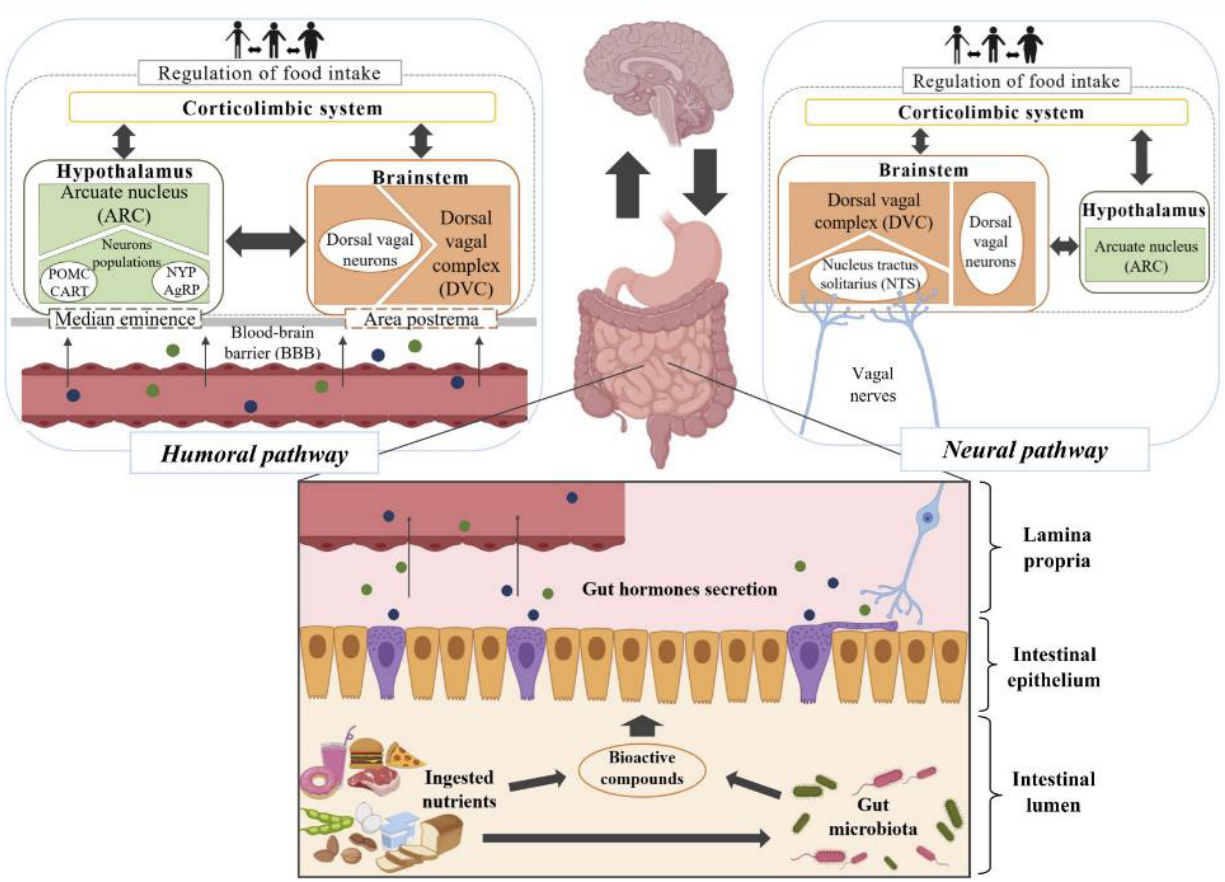
Figure 1. Scheme of the humoral and neural pathways connecting gut hormone secretion by enteroendocrine cells (EECs) and the different brain regions.